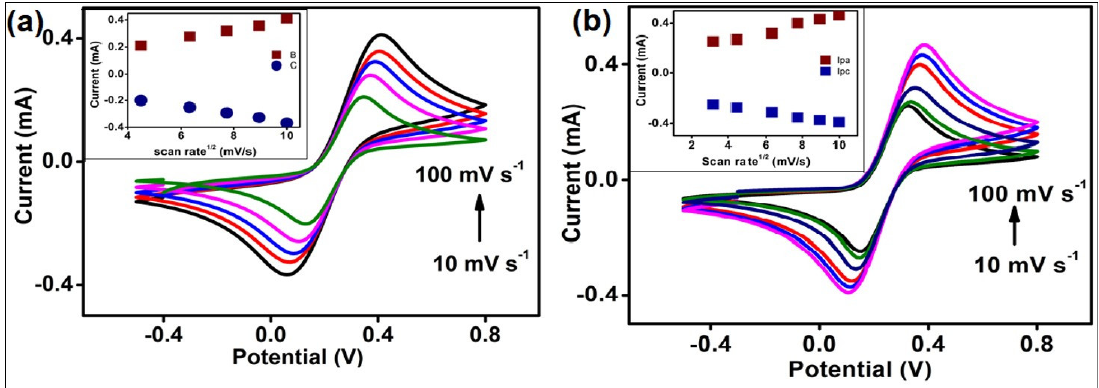
Figure 4. Cyclic voltammetry of ( a ) AuNCs/APTMS/ITO and ( b ) BSA/acTnI/Cys/AuNCs/APTMS/ITO and inset of ( a ) and ( b ) show the calibration plot of Ipa and Ipc with a scan rate of 10–100 mV/s.